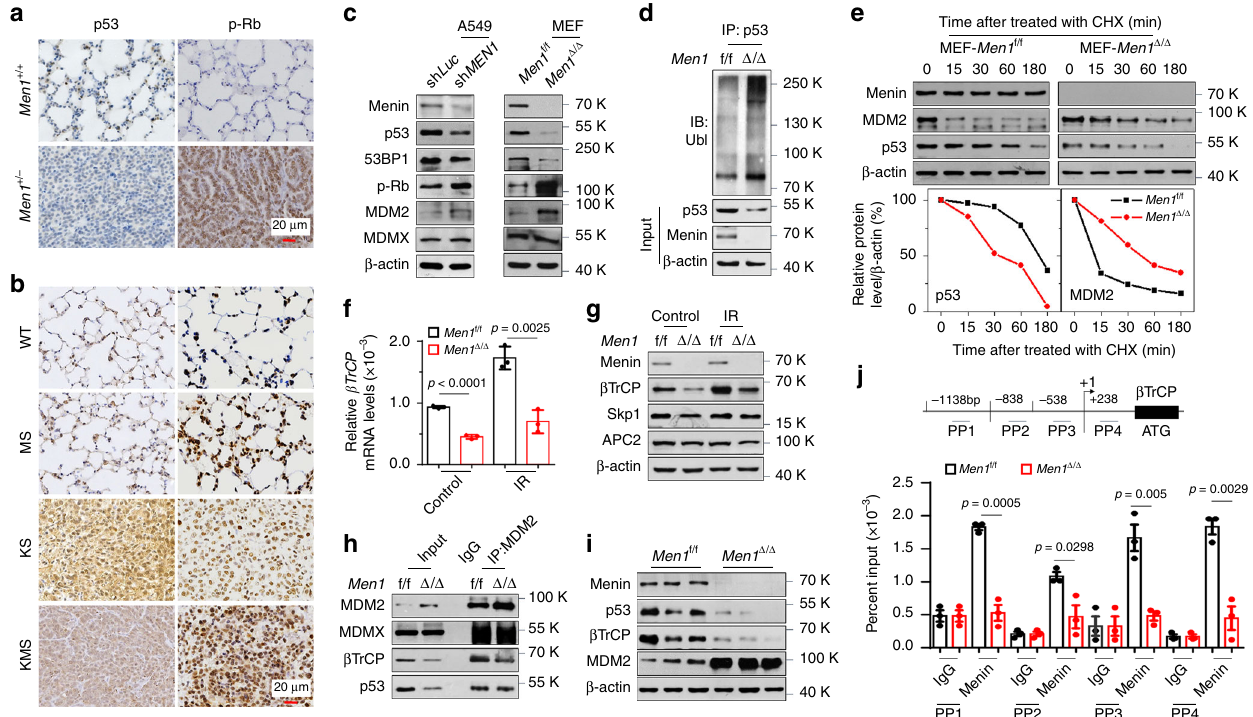
Fig. 3 Loss of Men1 leads to inactivation of the p53/Rb pathway. a , b IHC staining was performed with speci fi c p53 and p-Rb Ser780 antibodies in lung sections from mice of the indicated genotypes at 18 months a and 9 weeks b , respectively (from Figs. 1 and 2). The Men1 + / + , WT, and MS were normal lung tissues, the KS and KMS were lung tumors. Scale bars, 20 μ m. c Western blotting was used to detect the indicated proteins in A549 and MEF cells. d Co-IP with an anti-p53 antibody and ubi-p53 detection with an anti-ubiquitin antibody were performed via western blotting of samples from Men1 f/f and Men1 Δ / Δ MEF cells treated with 25 µ g/ml MG132 for 6 h. e Men1 f/f and Men1 Δ / Δ MEF cells were treated with 50 µ g/ml cyclohexamide (CHX), and the expression of menin, MDM2, and p53 was determined by western blotting (top). The relative expression of p53 or MDM2 was quanti fi ed by gray scanning, and the protein levels at the indicated time points are presented relative to those at 0 min (bottom). f RT-qPCR was used to detect the mRNA expression of β TrCP in Men1 f/f and Men1 Δ / Δ MEF cells 1 hour after exposure to 10 Gy of IR. g Western blotting was used to detect the expression of the indicated proteins in Men1 f/f and Men1 Δ / Δ MEF cells 1 hour after exposure to 10 Gy of IR. h Cell lysates were immunoprecipitated with anti-MDM2, and western blotting with MDM2, MDMX, β TrCP, and p53 antibodies was performed for Men1 f/f and Men1 Δ / Δ MEF cells. IgG served as the negative control. i Western blotting was used to detect the expression of MDM2, β TrCP, and p53 in the lung tissues/tumors of Men1 f/f and Men1 Δ / Δ mice ( n = 3 per group). j Schematic representation of the β TrCP gene promoter regions and primer pairs used for ChIP assays. ChIP-qPCR was performed with an anti-menin antibody on samples from Men1 f/f and Men1 Δ / Δ MEF cells, and IgG served as the negative control. Data are represented as mean ± SD in f , e and as mean ± SEM in j . Dots in f and j depict one repeat. Signi fi cance determined by two-tailed unpaired t tests in f and j are indicated. Results in c – i , and j are representative of three independent experiments. Source Data are provided as a Source Data fi and APC2 was inhibited by Men1 deletion but was not clearly affected by exposure to infrared (IR) (Fig. 3g). Simultaneously, the